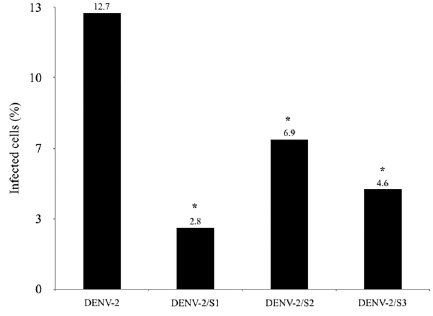
Figure 7. Quanti fi cation of the number of Vero E6 cells infected with dengue virus (DENV-2). Vero E6 cells were infected for four days with DENV-2 treated with saponins S1, S2, and S3, and then, the number of infected cells was determined by an immuno- staining assay. Uninfected Vero E6 cells and cells infected with untreated virus were used as controls. The number of infected cells after infection with DENV-2 treated with saponins was compared with the number of cells infected with the untreated virus in 20 random fi elds to determine the rate of inhibition of viral infection. *P o 0.001 between cells infected with treated and untreated virus (Fisher ’ s exact test).